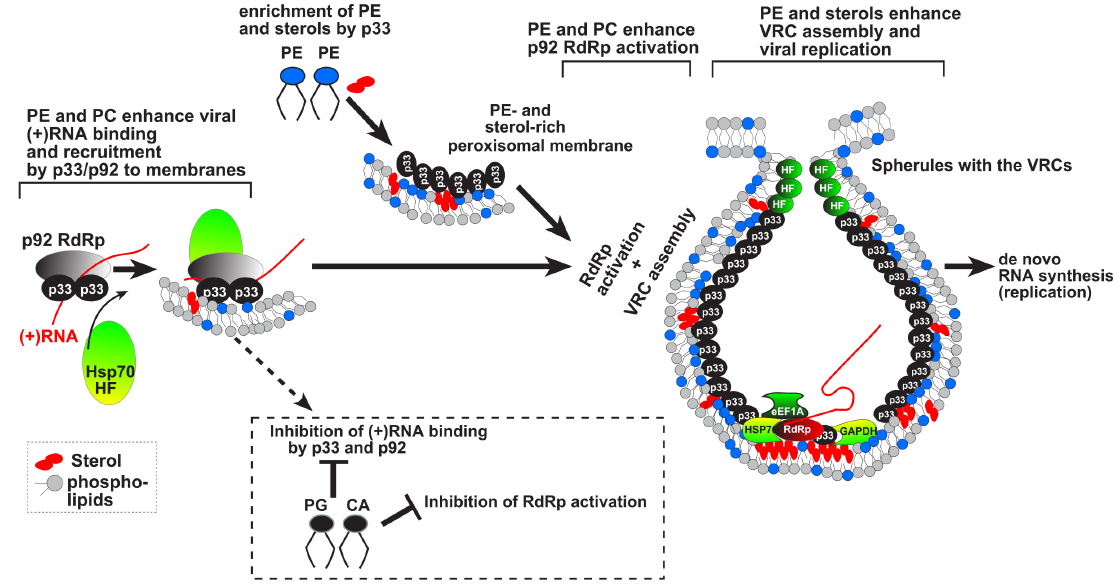
Figure 1. Stimulatory versus inhibitory roles of various cellular lipids in TBSV replication. While neutral phospholipids and sterols stimulate the assembly of the membrane-bound tombusvirus VRCs, other lipids could strongly inhibit virus replication. See further details in the text.